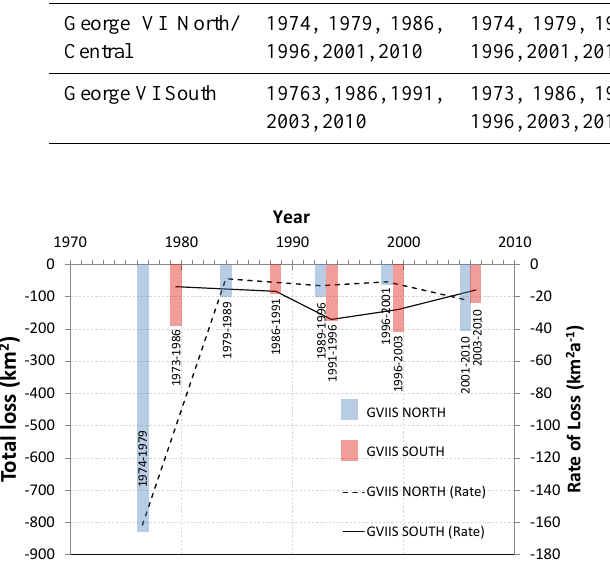
Fig. 3. Total ice loss (bars) and rate of loss (lines) for GVIIS north and GVIIS south ice fronts between ca. 1973 and 2010. Note the major ice loss event between 1974 and 1979 at the north ice front followed by a period of comparatively steady retreat. Loss at the south ice front is more regular across the observation period, al- though retreat rate doubles between 1990 and 1995. There is no relationship between ice loss quantity or timing between the north and south ice